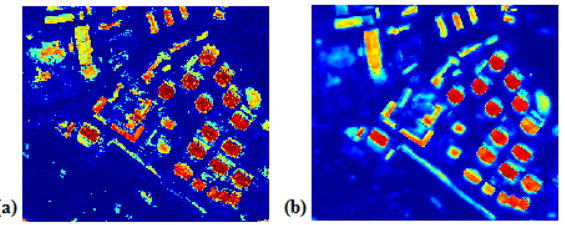
Figure 2. BPMs before (a) and after (b) the refinement.